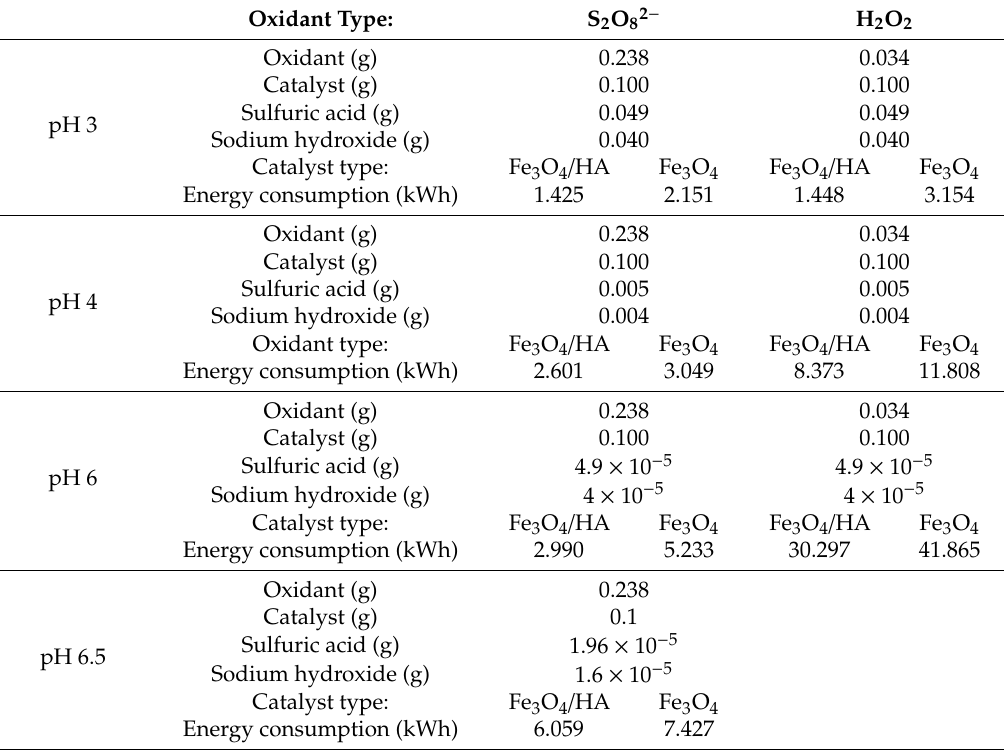
Table 11. Inventory of the input related to the treatment of 1 L of Milli-Q water contaminated with BPA (20 µ M).